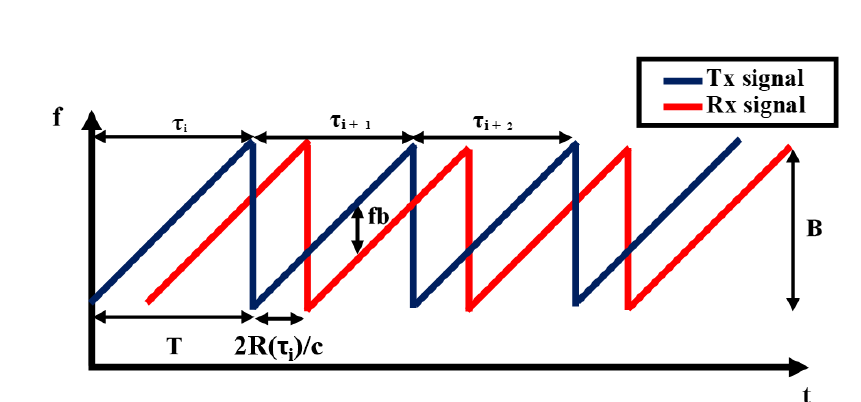
Figure 2. Working principle of FMCW radars. B stands for the transmitted bandwidth, T is the repetition period and 2 ∗ R ( τ i ) / c is the round-trip delay, i.e., the time that the transmitted signal takes to be returned to the radar by a target at R ( τ i )